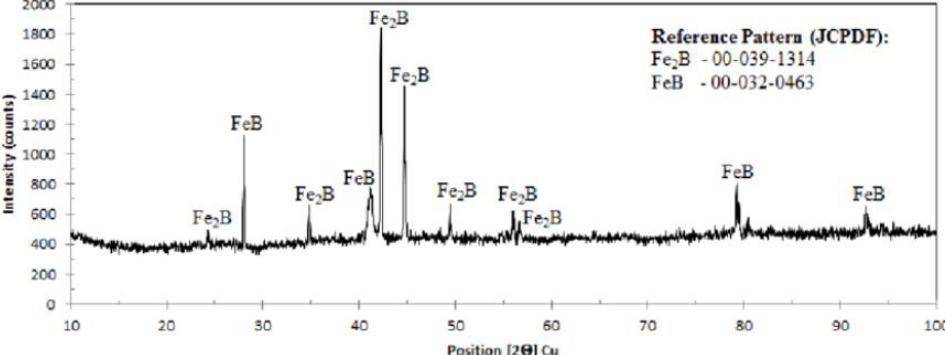
Figure 5. The phase inclusion of ferrous boride (for reference only); JCPDS file [48]; adapted with